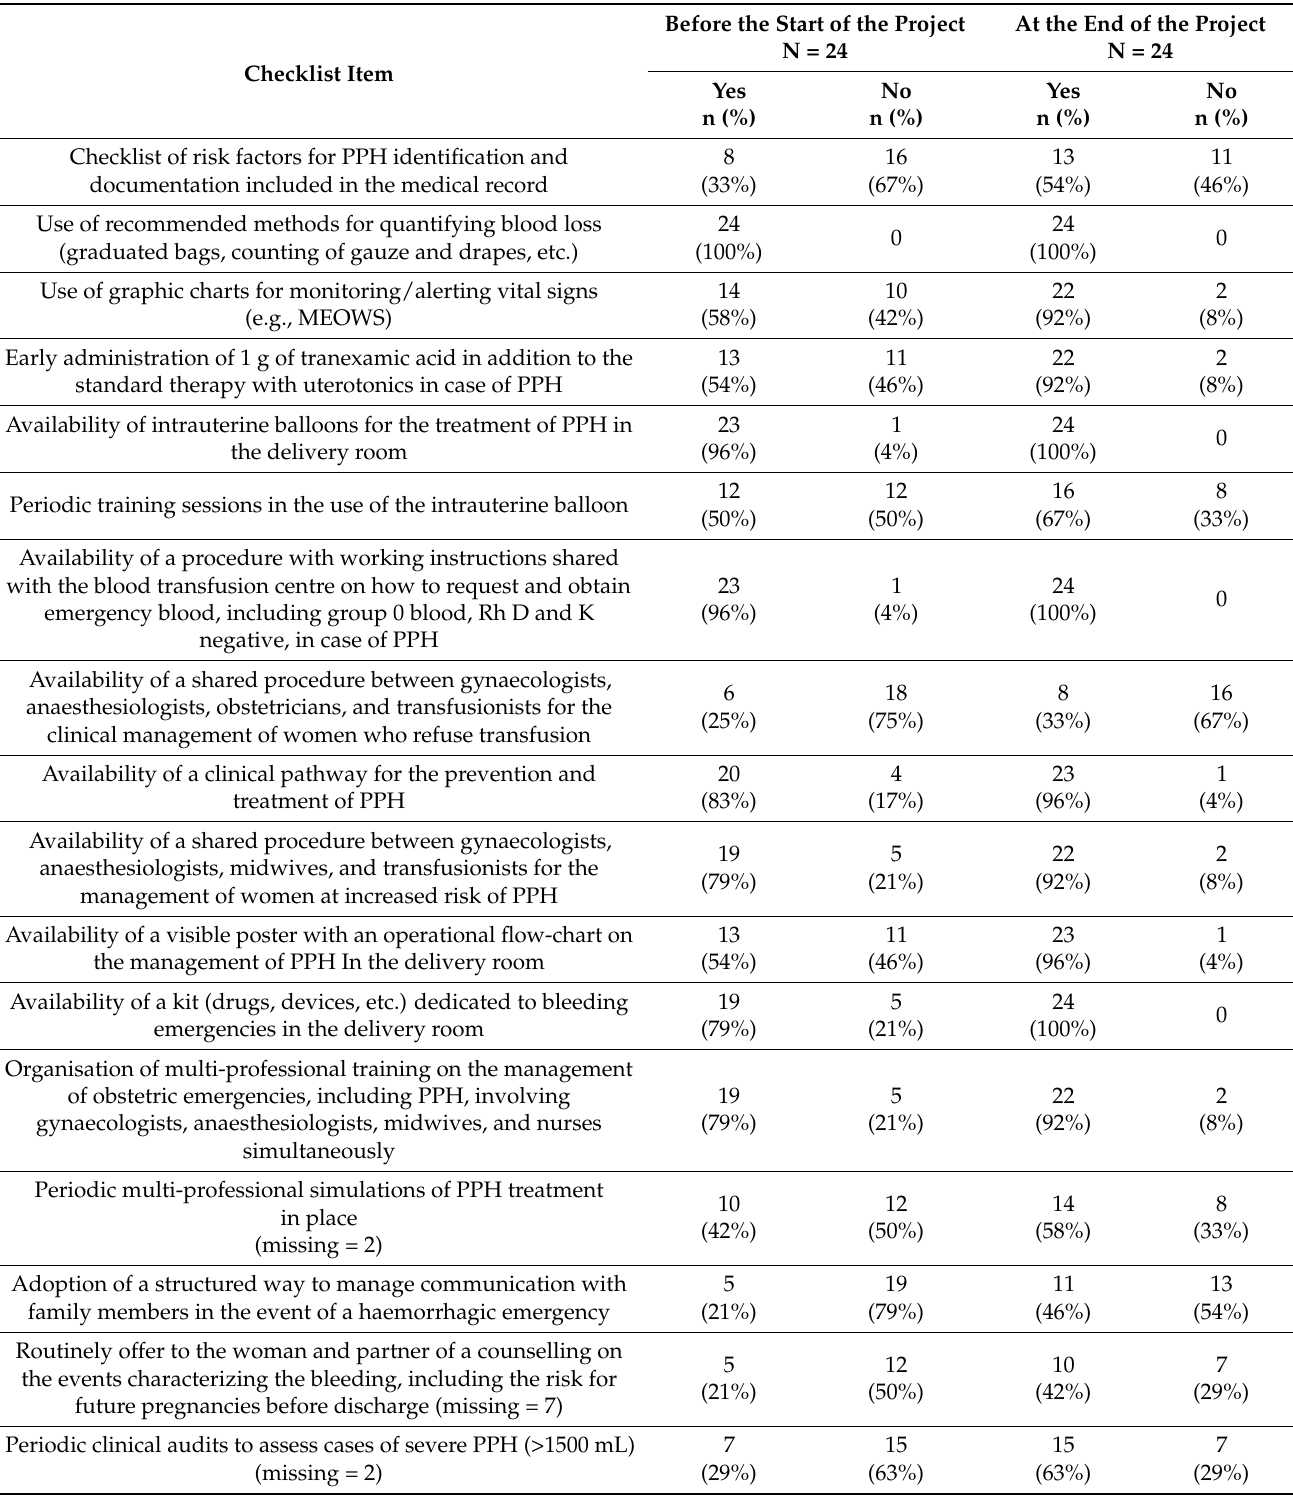
Table 1. Before–after checklists compiled by the contact clinicians at the Maternity